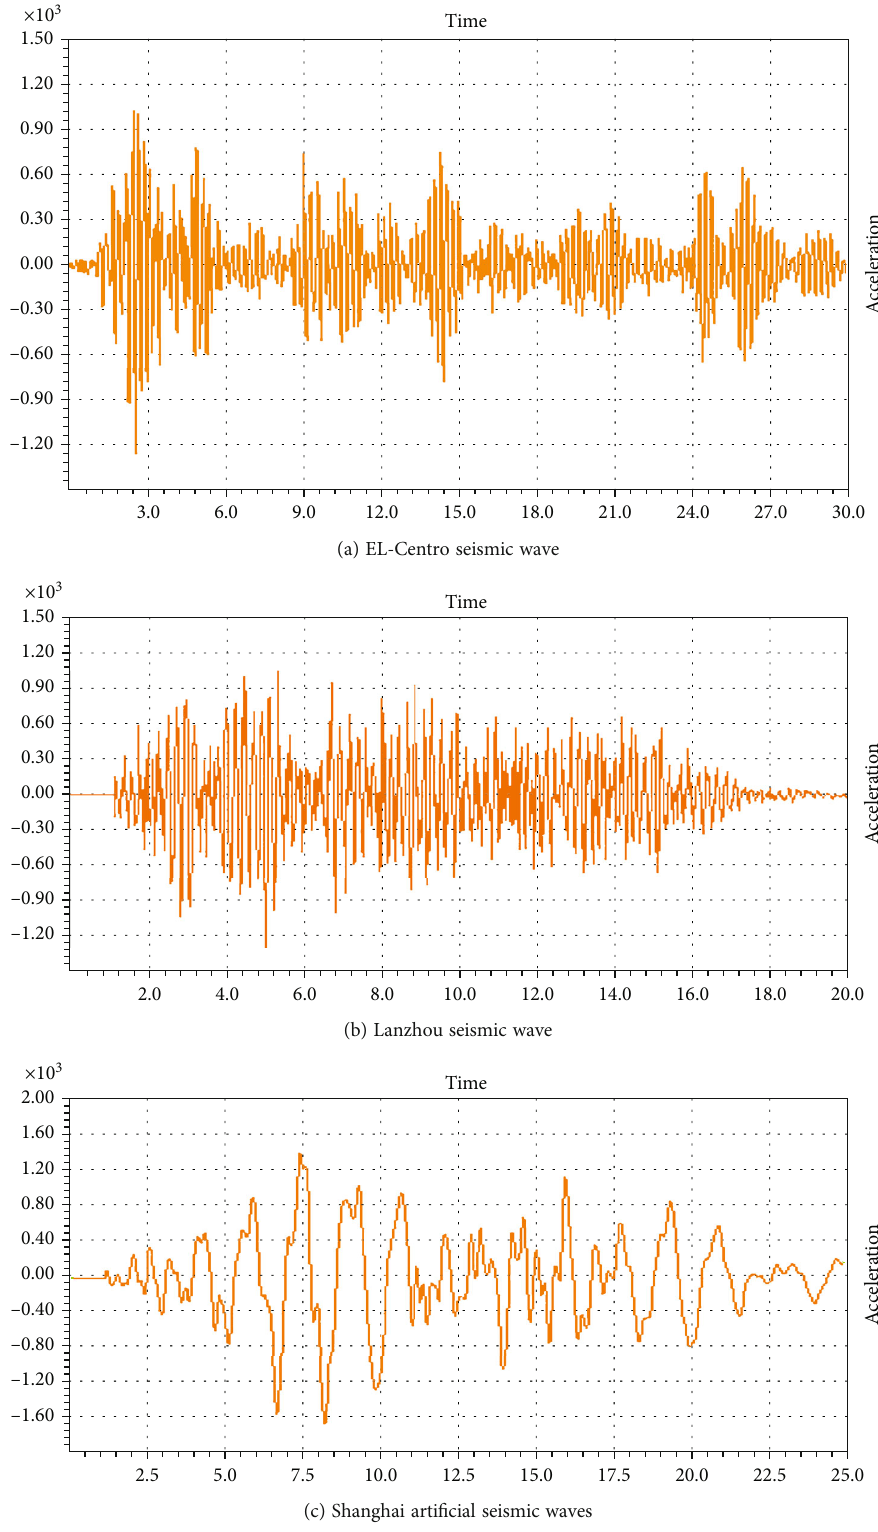
Figure 4: Seismic wave